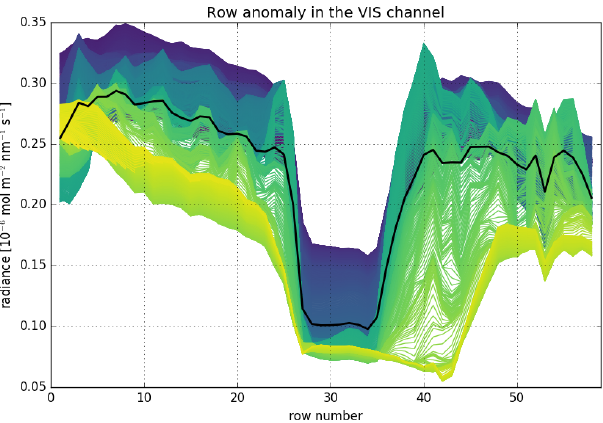
Figure 18. Row anomaly monitor results for the VIS channel. Here the radiance data from orbit 50000 are averaged over all columns, after which the running standard deviation is determined over 300 neighboring measurements in time. The colors indicate the sequence of measurements in the orbit, starting with dark blue over the South Pole and changing via green to light yellow towards the end of the orbit over the North Pole. The figure shows low values for anomalous rows for the whole duration of the orbit, while the disturbed row range increases towards the end of the orbit.